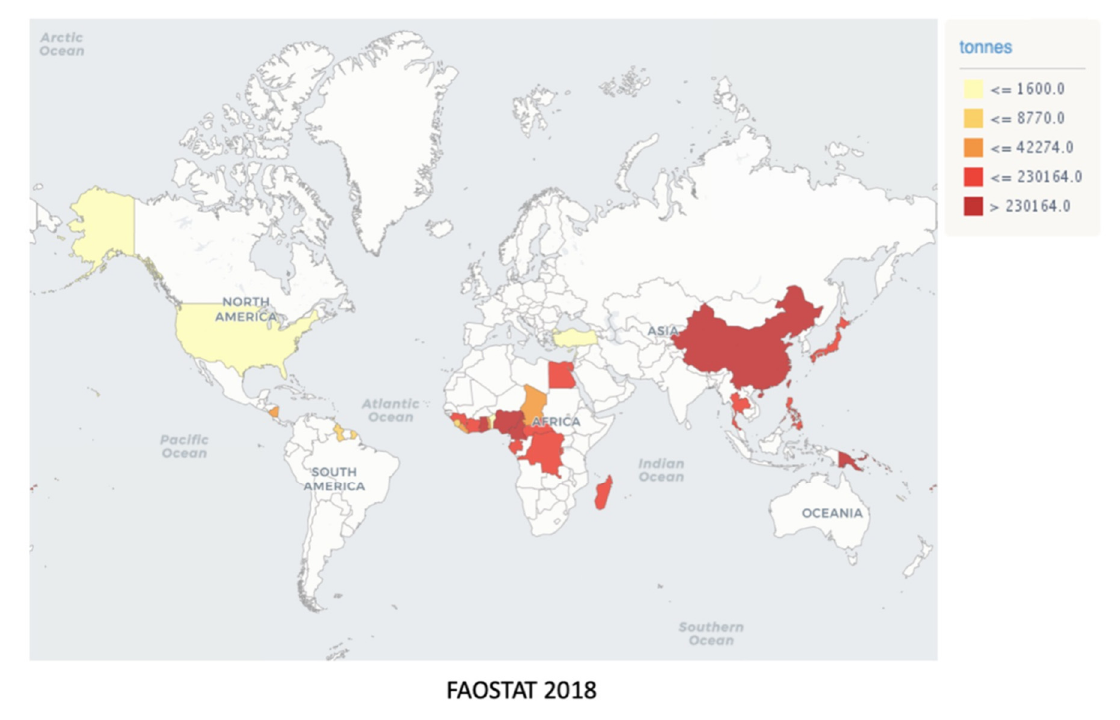
Figure 1. Global distribution of taro production reproduced from FAOSTAT (http://www.fao.org/faostat/en/#data/QC). Quantitative taro production per country in 2018, repreScheme 230. tons followed by the USA, Canada, and Cyprus with production lower than 1600 tons. Uncolored countries represent production areas under 1000 ha. Table 1. Nutritional composition of taro analyzed raw, cooked and baked.